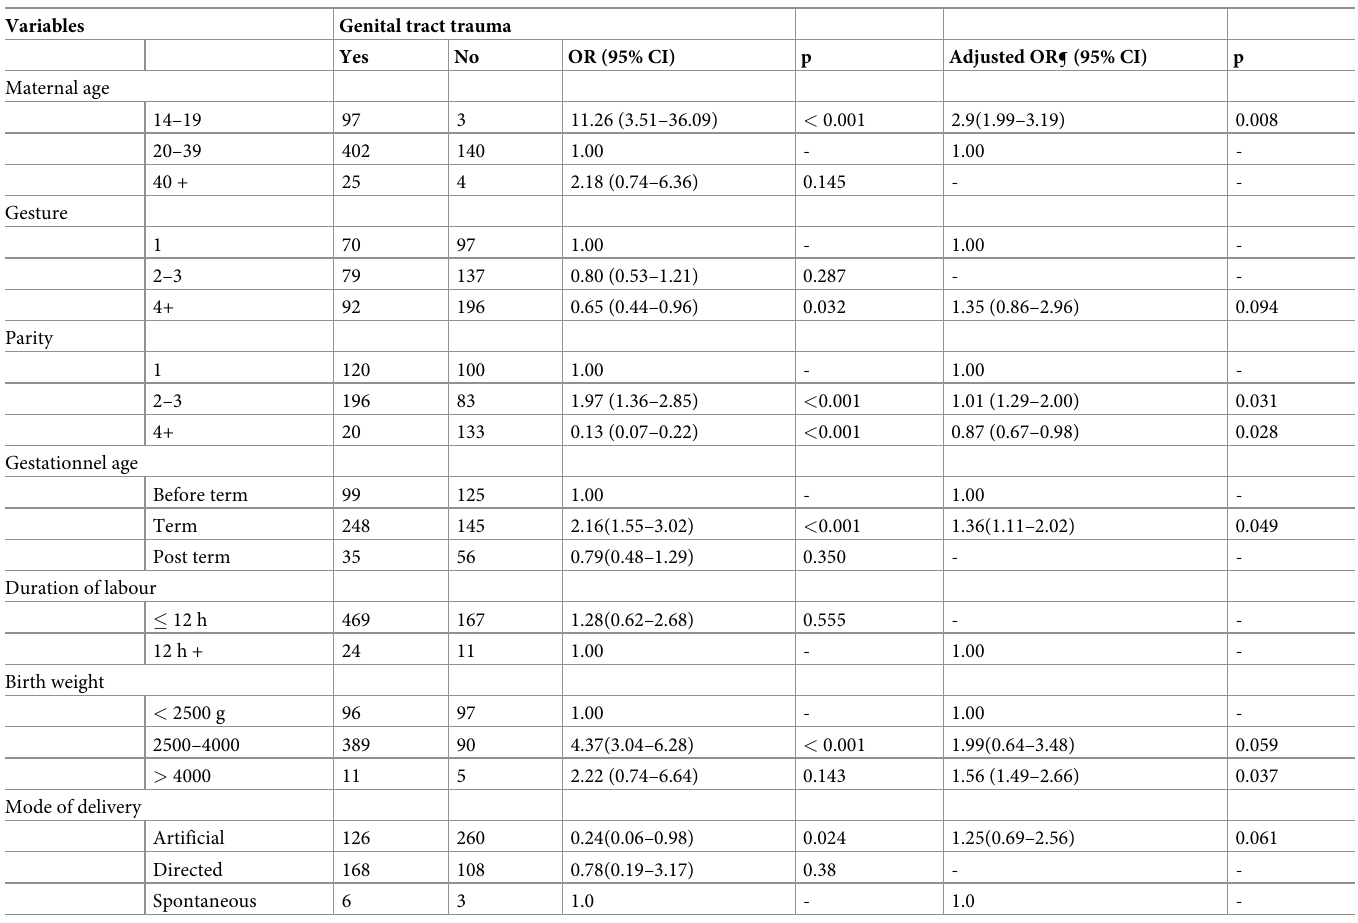
Table 5. Risk factors for PPPH with etiologies such as genital tract trauma in parturients.